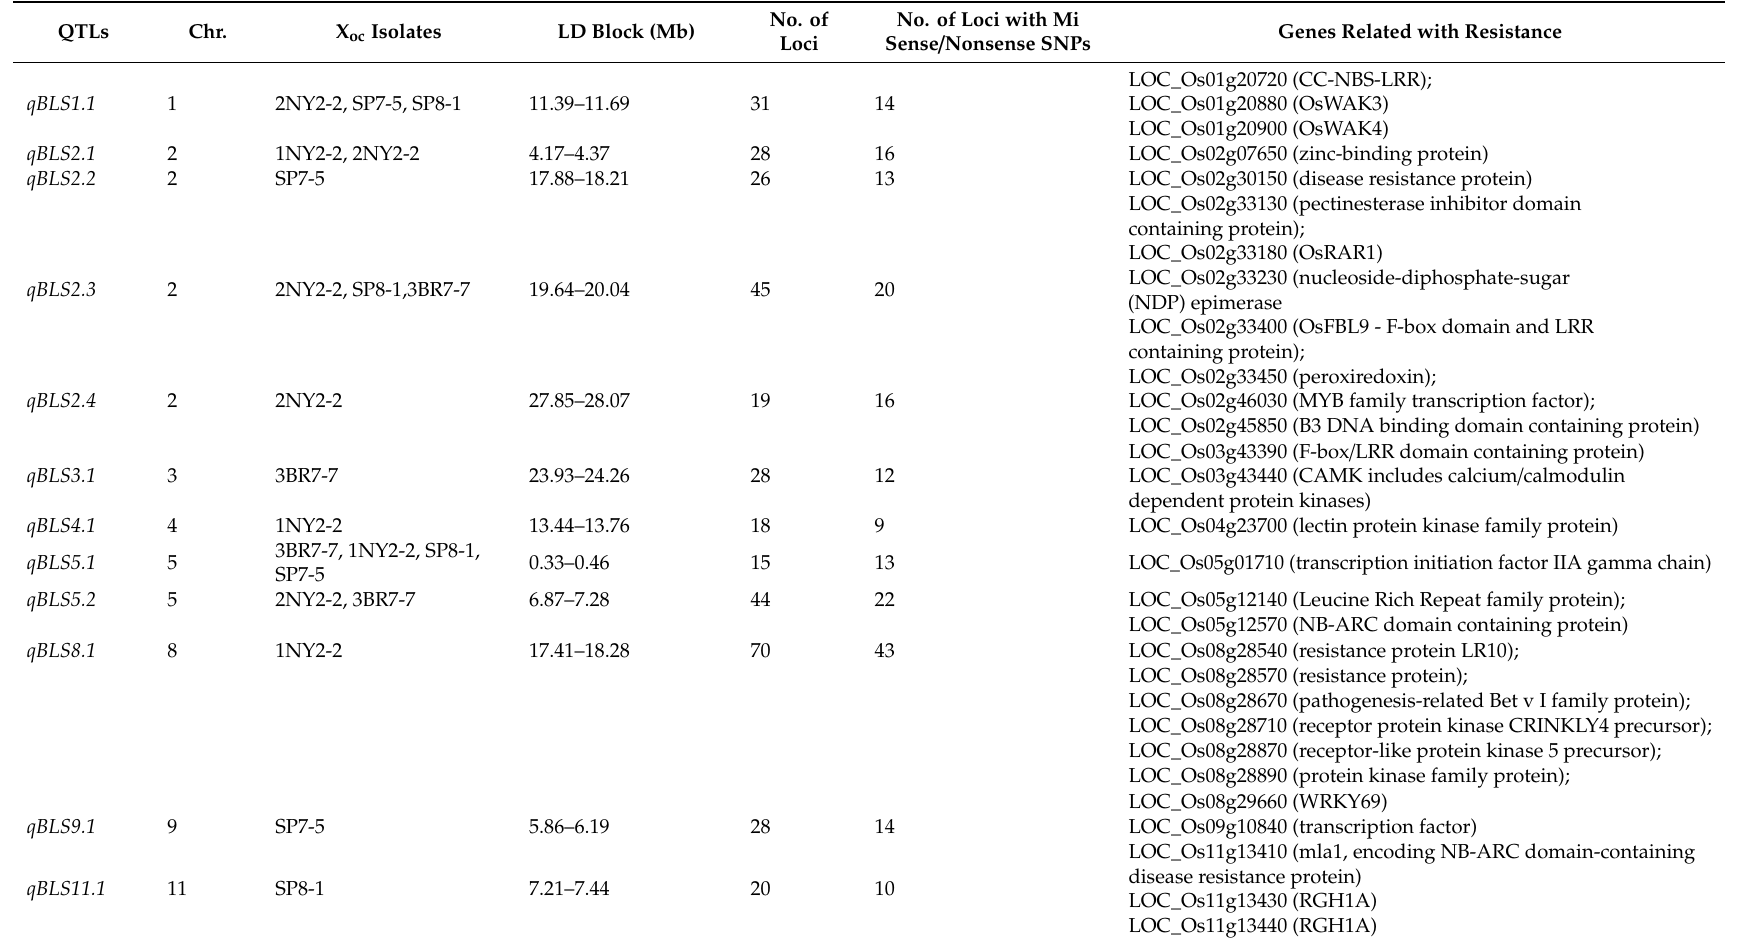
Table 2. Twelve regions associated with the resistance to five Xoc isolates based on a